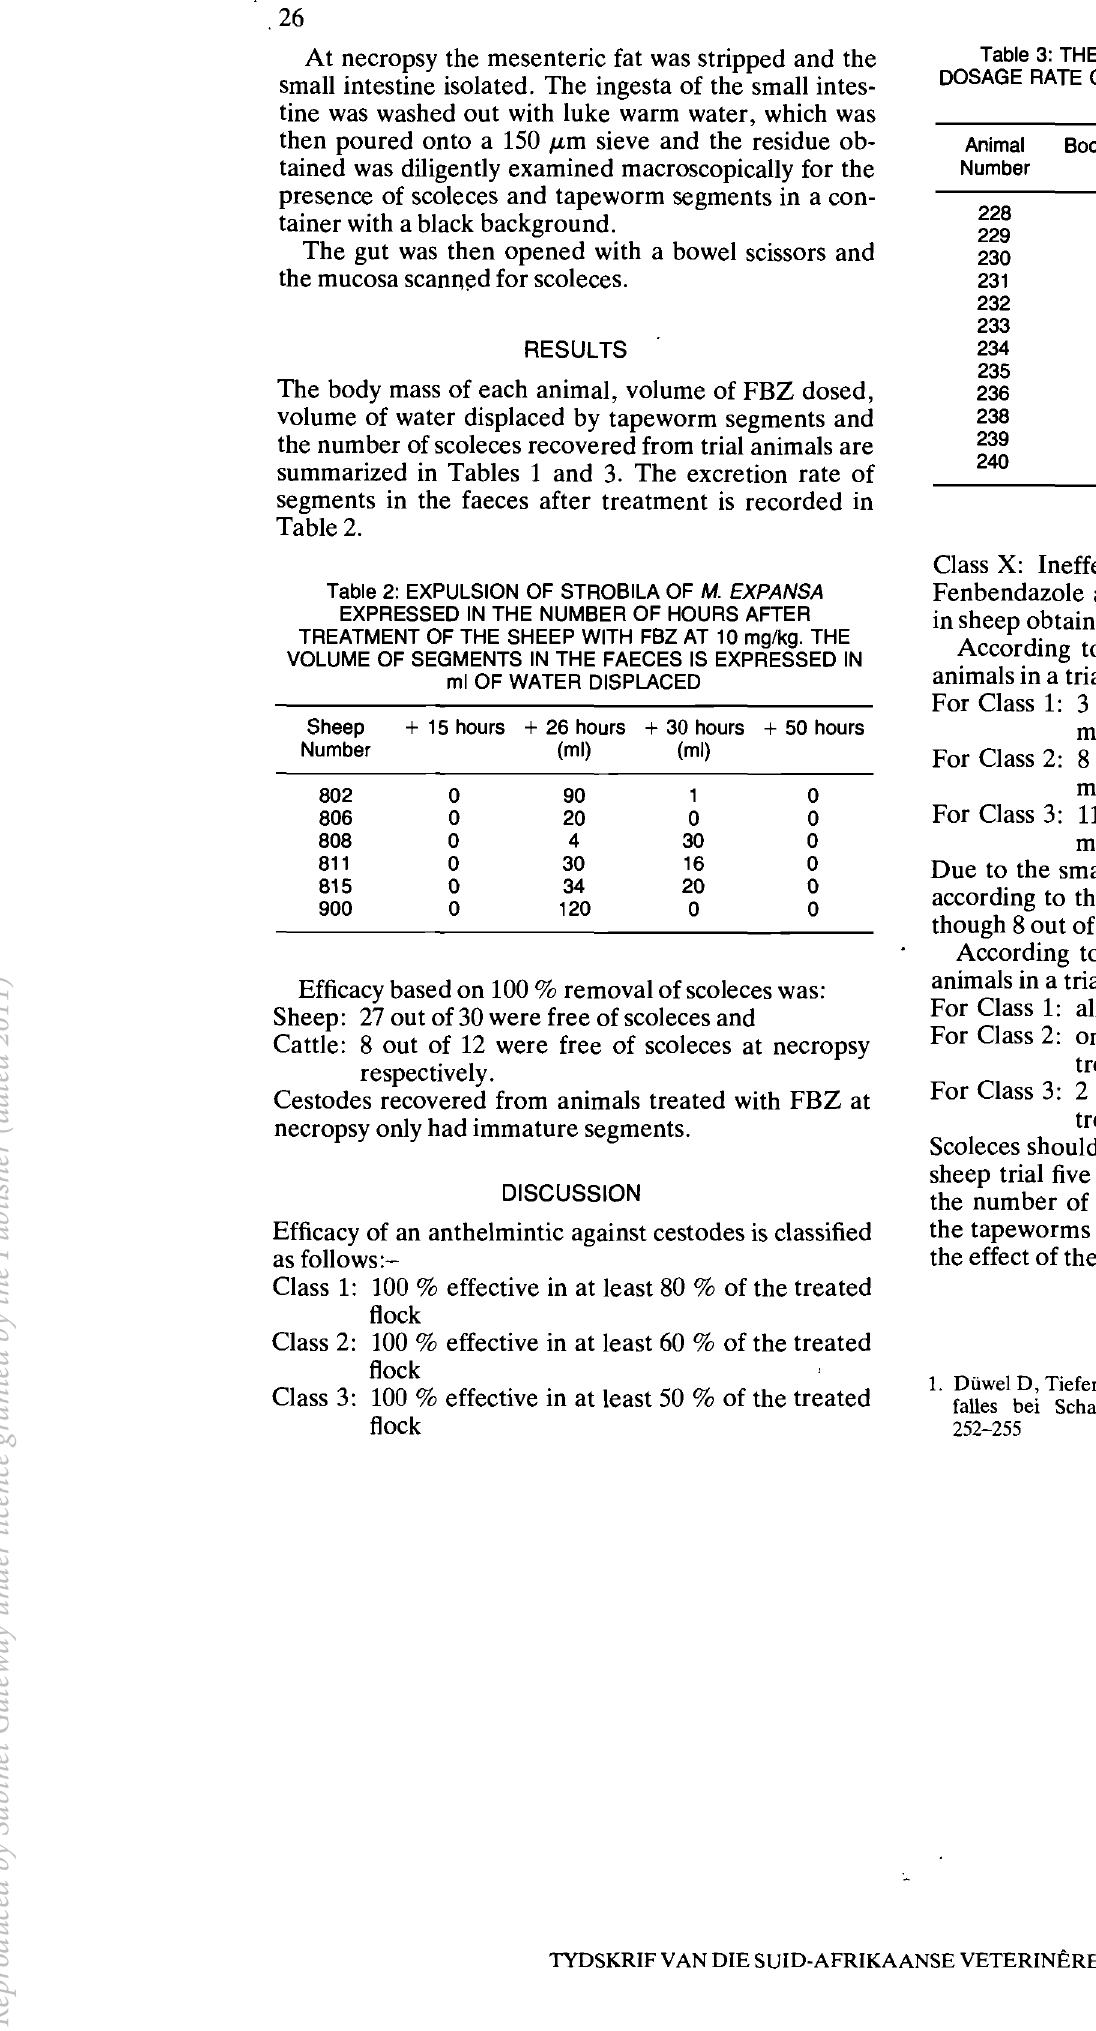
Table 3: THE ANTHELMINTIC EFFICACY OF FBZ AT A DOSAGE RATE OF 10 mg/kg BODY MASS AGAINST MONIEZIA SPP. IN CATTLE